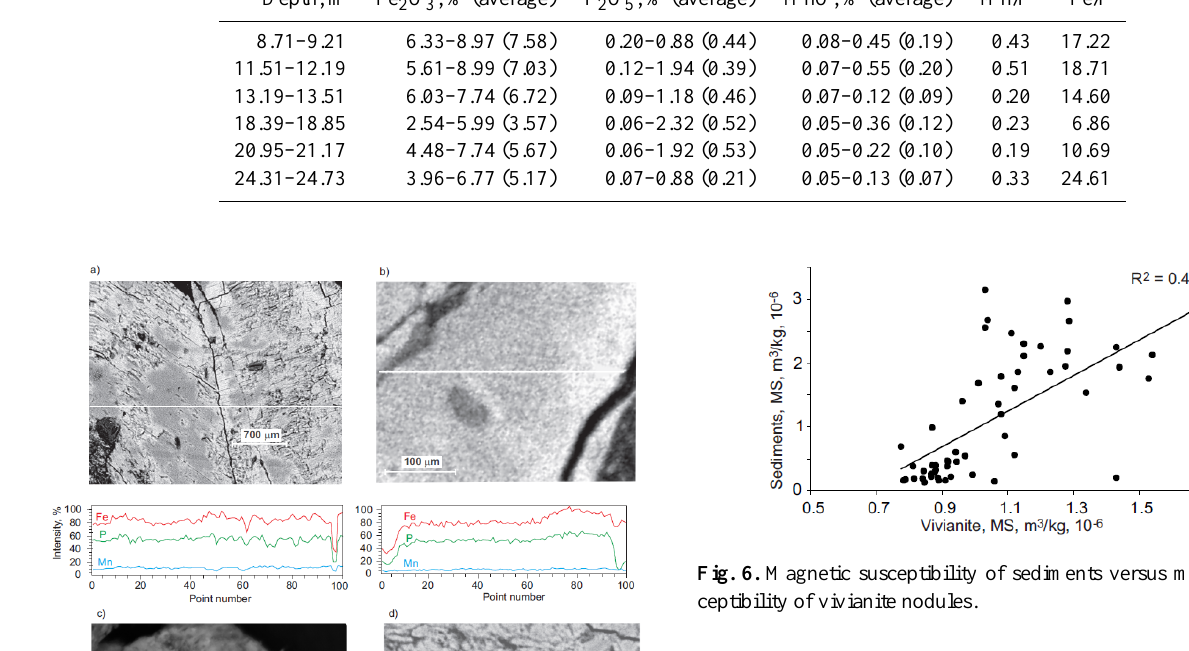
1.8 × 10 − 6 m 3 kg − 1 ), n = 374. As plotted in Fig. 6, there can